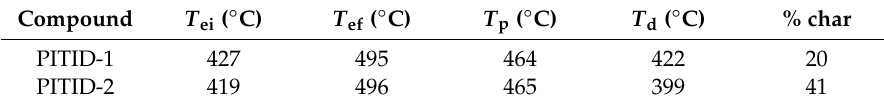
Figure S1: 1 H NMR spectra of the copolymers PITID-1 (a) and PITID-2 (b). Figure S2: High-resolution XPS